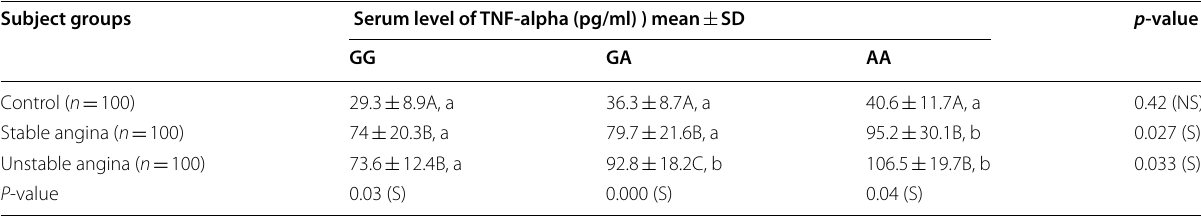
ANOVA test. Different capital letters mean there are significant differences between subject groups with the same genotype, and different small letters mean there are significant differences between genotypes with the same group. NS non-significant P > 0.05; S significant P